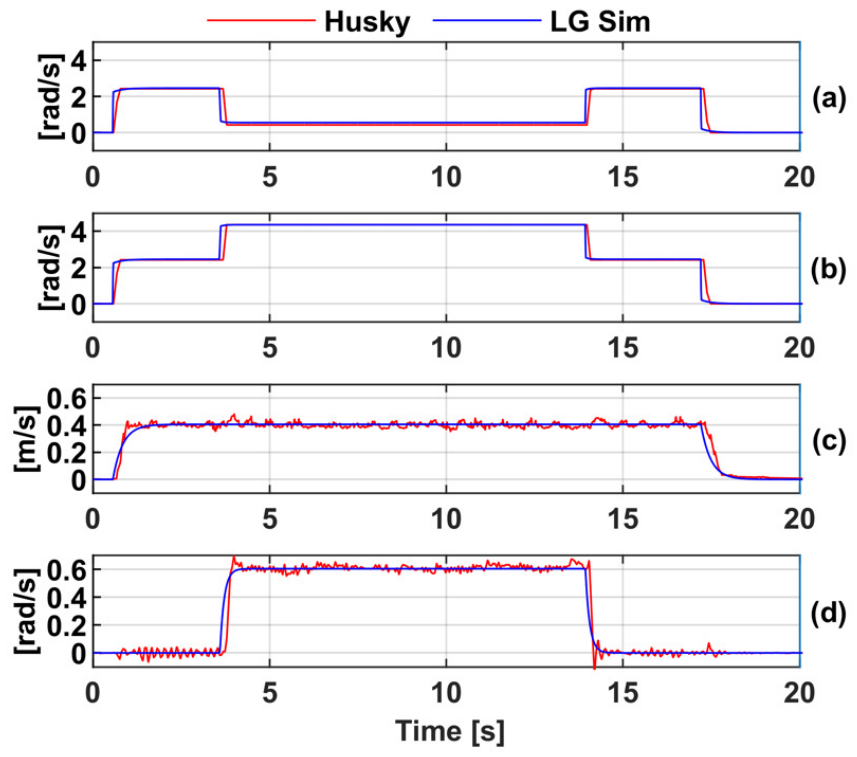
Figure 13. Response of ( a ) left- and ( b ) right-side wheel velocities and the ( c ) linear and ( d ) rotational velocities of the Husky LG model and the measured Husky data.